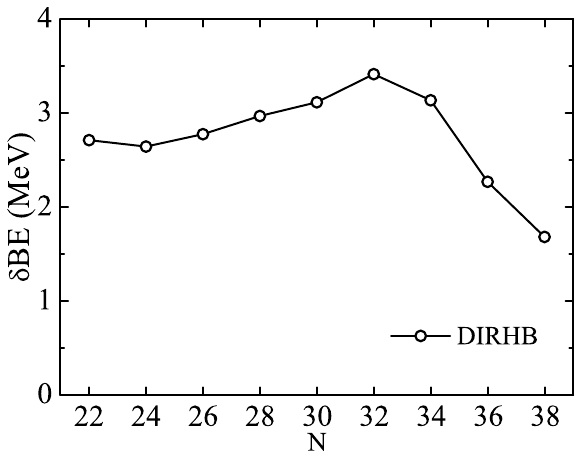
Figure 1. The di ff erence between DIRHB calculated and the corresponding experimental [13] binding energies for even Cr isotopes.